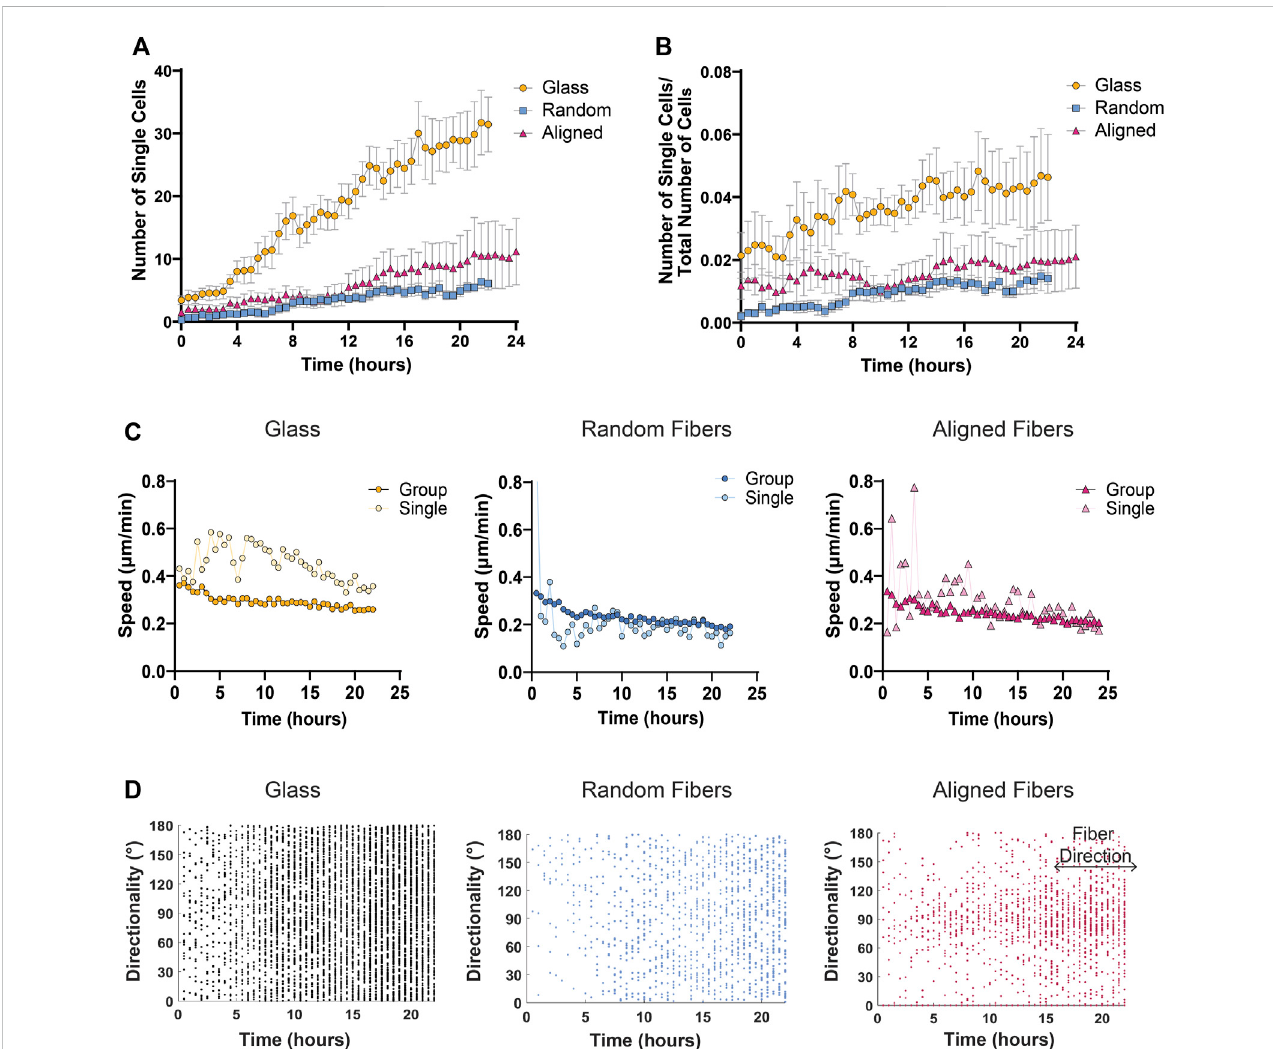
FIGURE 5 SinglecellmigrationmetricsofMDA-MB-231spheroidsmigratingonglassand fi bersurfaces. (A) Thenumberofsinglecellsdetachedfromthecellsheet overtime. (B) Differencesinthenumberofsinglecellsoverthenumberoftotalcellstoaccountfordifferencesintotalnumberofcellsdetected. (C) Meancell speedofcollectivecellgroupsorsinglecellsonvarious fi bermatsovertime. (D) Directionalityofsinglecellsovertimeonglass,random fi bermats,andaligned fi ber mats with fi bers at 90 ° direction for aligned fi ber mats. Each dot represents the instantaneous directionality of one single cell. Analyses were performed on seven spheroids on glass, 11 spheroids on random fi bers, and 11 spheroids on aligned fi bers ( n ≥ 3 biological replicates). All data presented as mean ±